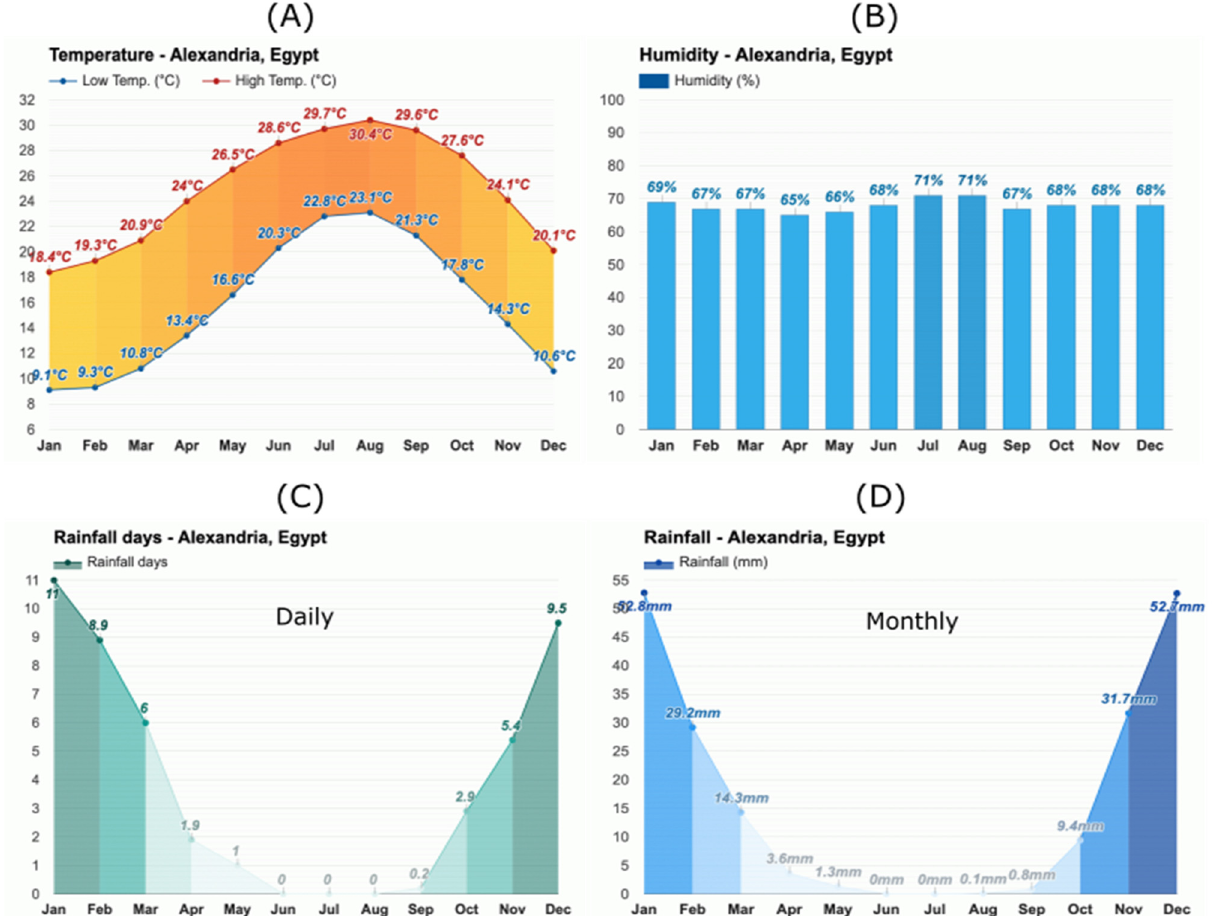
Figure 9. ( A – D ) Hyetographs for meteorological average data in Alexandria 2021 of temperature ( A , in °C), relative humidity ( B , in %), rainfall days ( C , in number of days) and rainfall ( D , in mm). After https://www.weather-atlas.com/en/egypt/alexandria-climate. Accessed 19 May 2022. Table 2. Wind dynamics in Alexandria, monthly in 2021 (after https://www.time- anddate.com/weather/egypt/alexandria/historic?month=12&year=2021, Accessed 23 May 2022). Wind Speed (km/h).